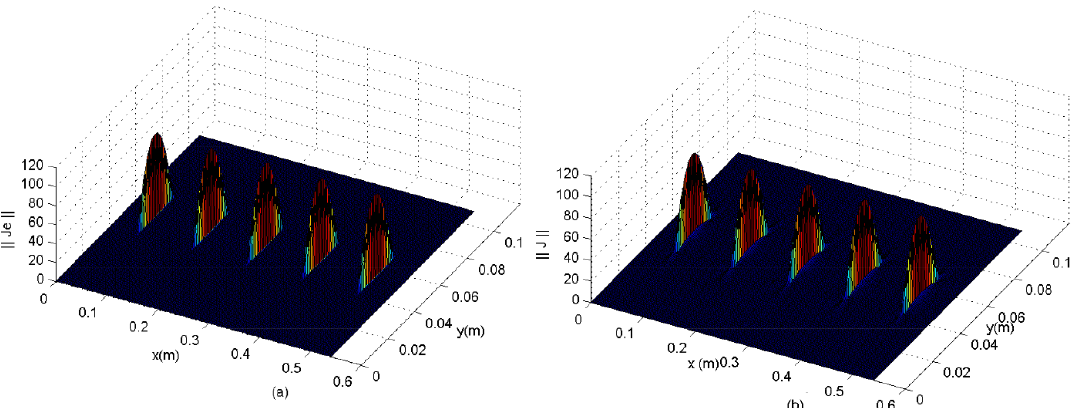
Figure 11. Current density of the almost periodic network (half-wave dipoles) defined on the aperture of the waveguide, described by ( a ) the test functions or ( b ) the basic functions (guide modes) at the operating frequency (f) of 5.4 GHz. The physical parameters used were: α 0 = 0 rad m − 1 , β 0 = 0 rad m − 1 , w = 1 mm, δ = 0.75 mm ( w (cid:28) λ 0 , δ (cid:28) λ 0 ) , d x = 108 mm, d y = 108 mm,